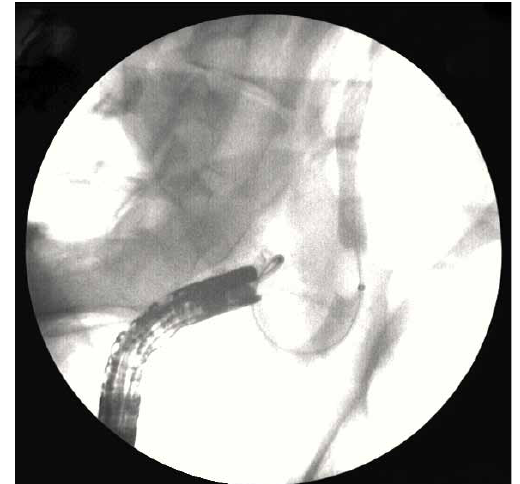
Figure 3 - Retrograde endoscopic catheterization of ureteral